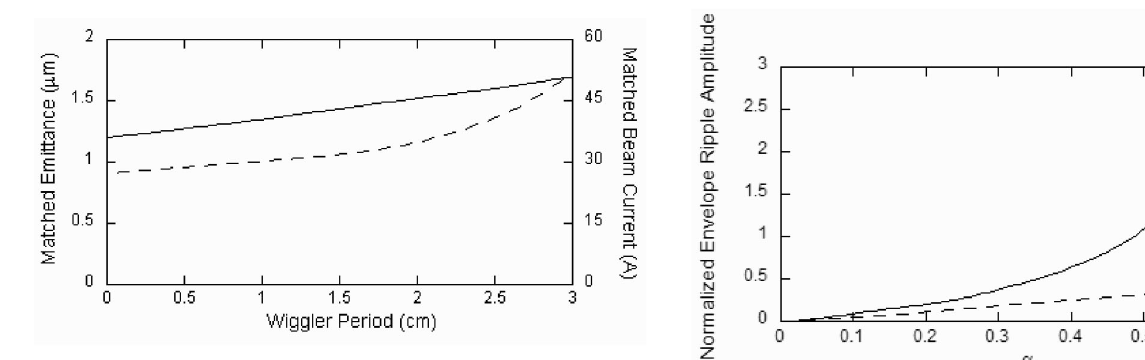
FIG. 10. Fractional ripple as a function of (cid:6) . The solid line is for the case of an emittance-dominated beam and the dashed line is for the case of a space-charge dominated beam.